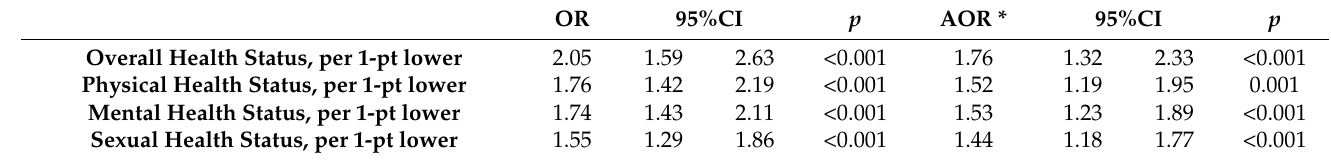
Table 3. Association with Health Status and high HIV treatment and disease burden